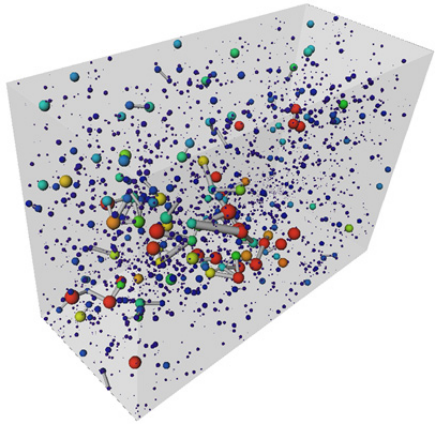
Figure 13. PNM of CZ-Y47-1.